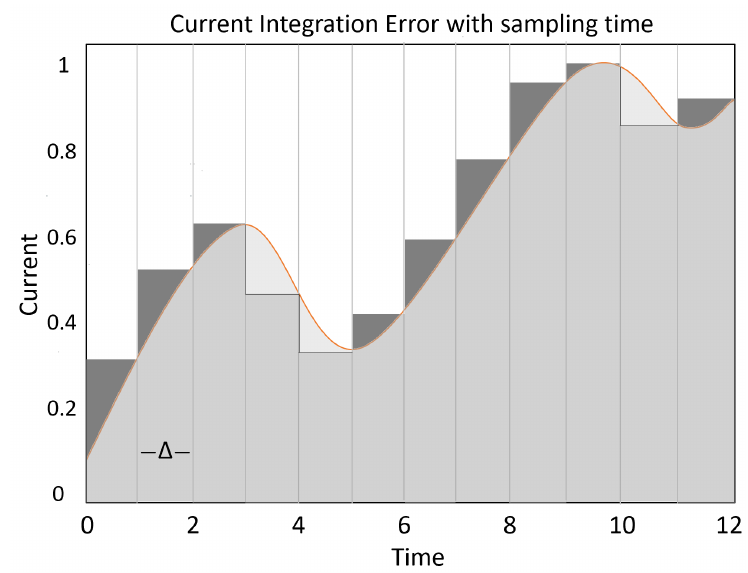
Figure 1. A representation of the current integration error. The positive integration error is shown by dark shade and negative error by light